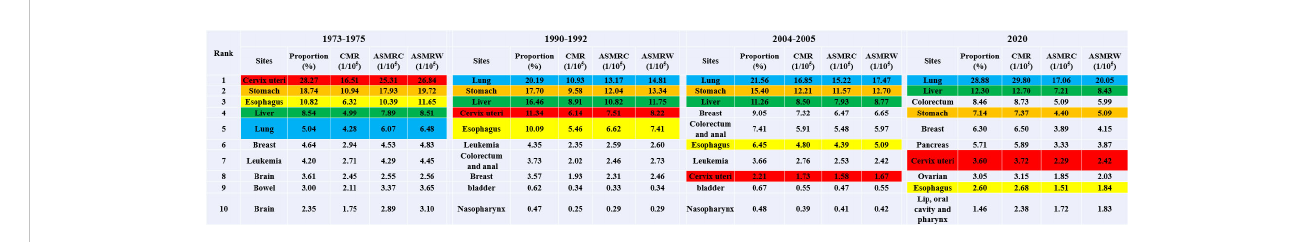
FIGURE 3 The top 10 cancer rank in female during the four periods in Inner